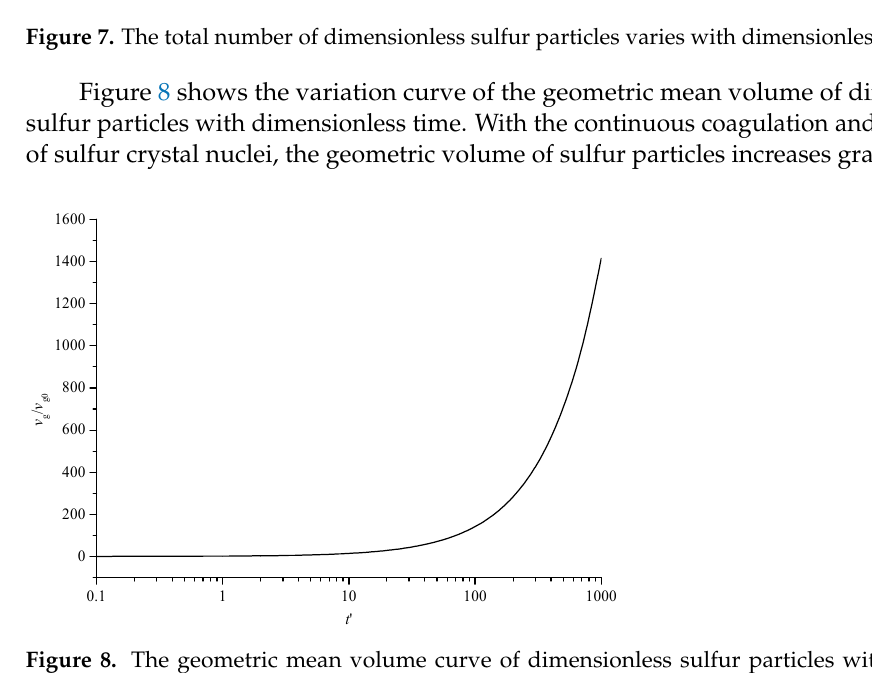
Figure 8. The geometric mean volume curve of dimensionless sulfur particles with dimensionless time.